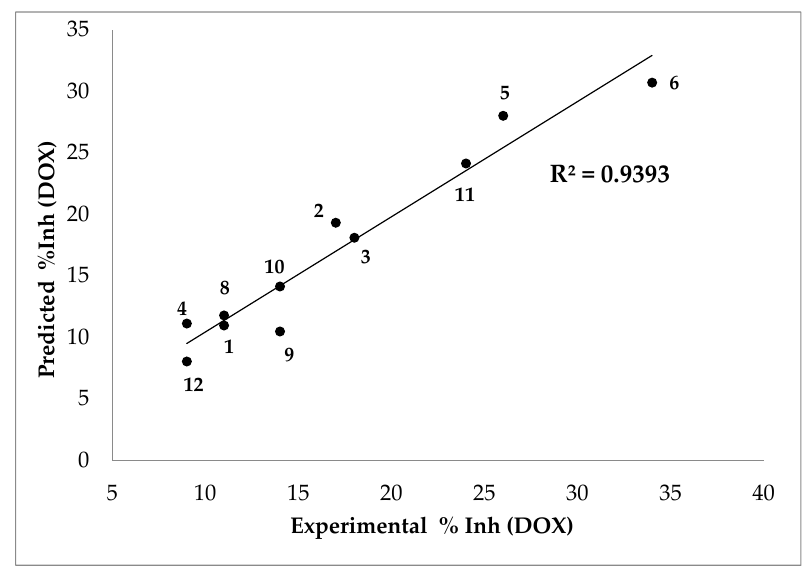
Figure 6. Predicted vs. experimental percentage inhibitions results in DOX assay. Compound 7 was excluded from the analysis (see text).